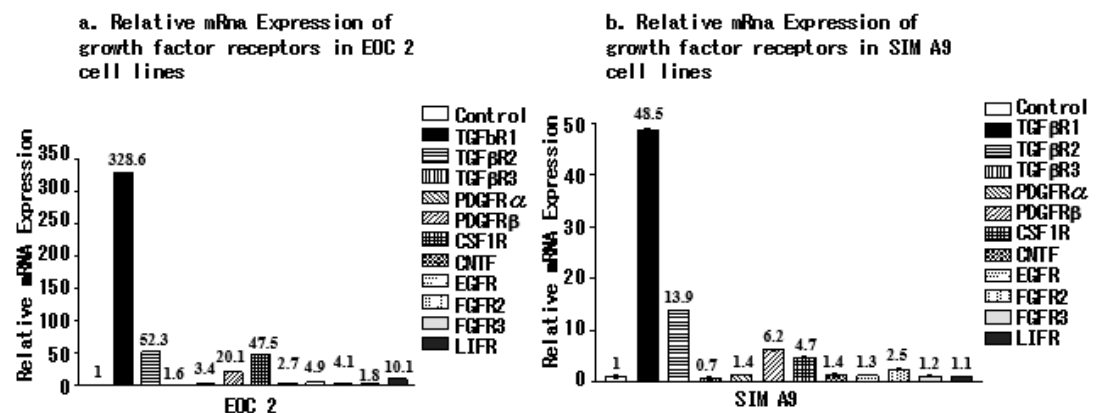
Figure 3. TGFβR2, TGFβR3, PDGFRα, PDGFR β , CSF1R, CNTFR, EGFR, FGFR2, FGFR3, and LIFR are expressed by both EOC 2 and SIM A9 cell lines. TGFβR1, TGFβR2, PDGFR β , and CSF1R were highly expressed in both cell lines compared with the other growth factors.